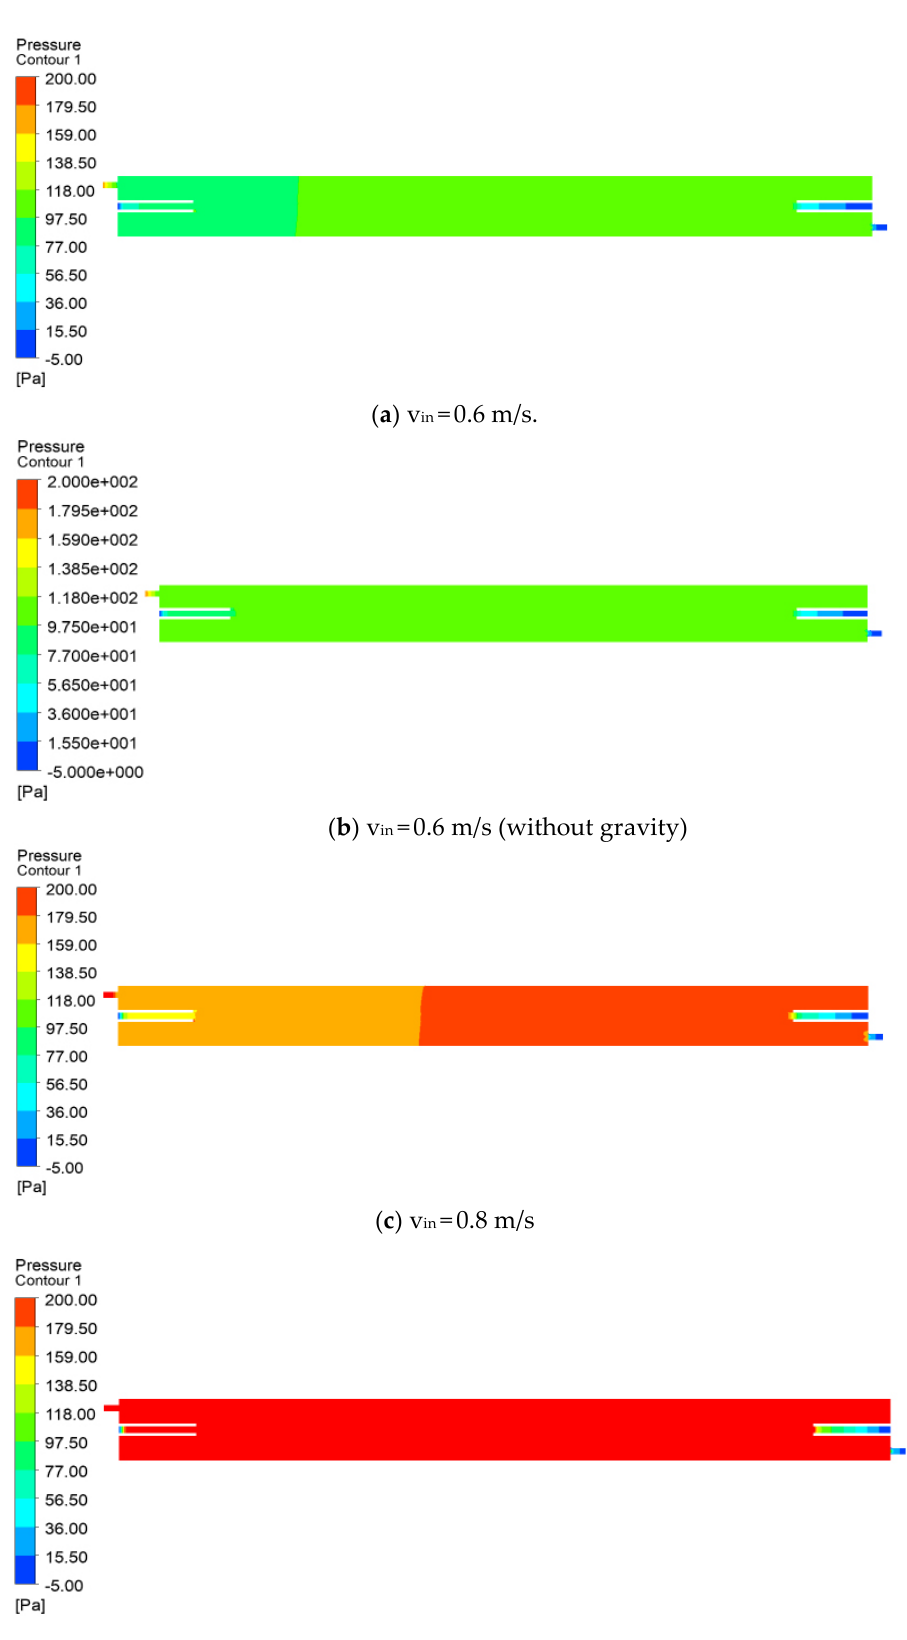
Figure 6. Pressure contour on X = 0 section.